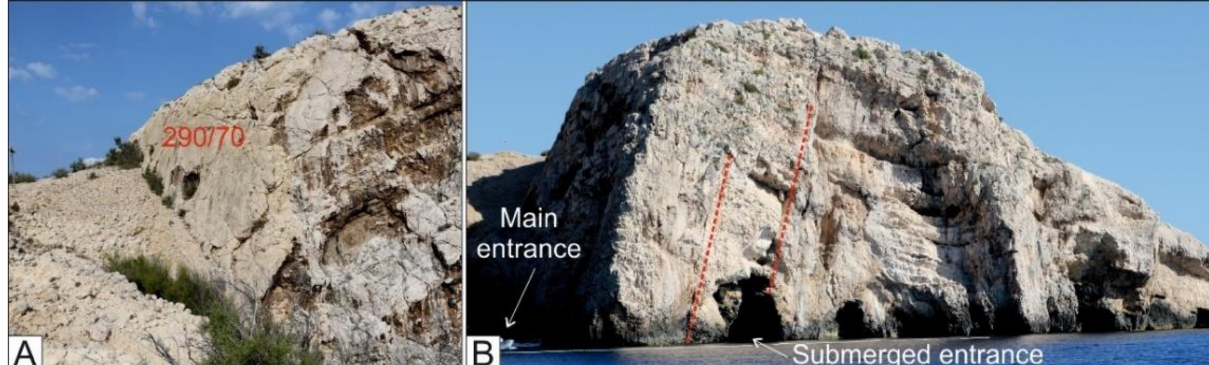
Figure 3. ( A ) The Blue Cave fault plane above the main entrance to the cave. ( B ) Vertical cliff on the eastern side of the Blue Cave, host rock, and marked fracture systems (red dashed lines) also measured inside the cave. The cliff is approximately 40 m high (small boat at the main entrance for the scale).